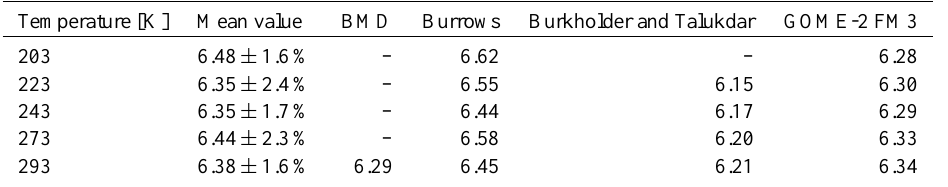
Table 5. Comparison of integrated cross sections in the Chappuis band (410–690nm) in units of 10 − 19 cm 2 nmmolecule − 1 , the second column indicates the mean from all available literature (Orphal, 2002).